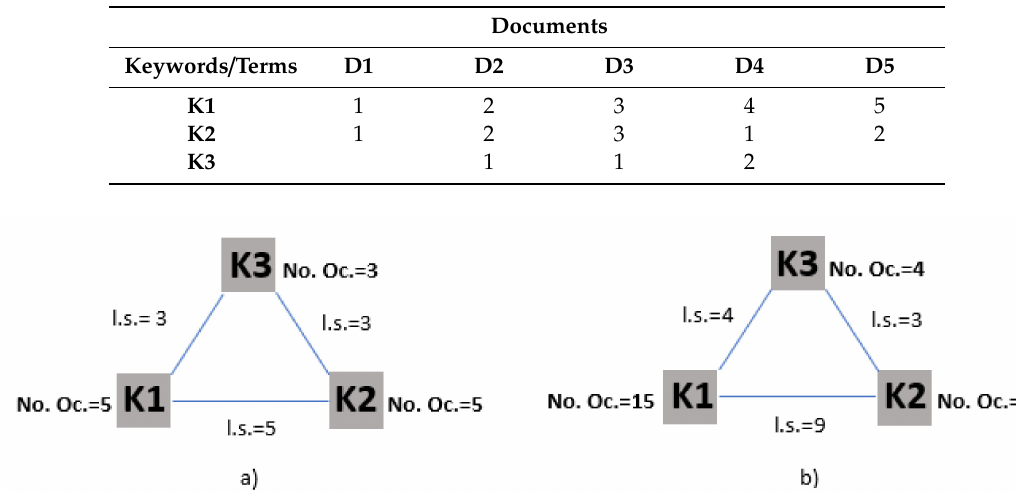
Table 1. Number of occurrences of keywords ( K 1-3 ) in documents (D 1-5 ).